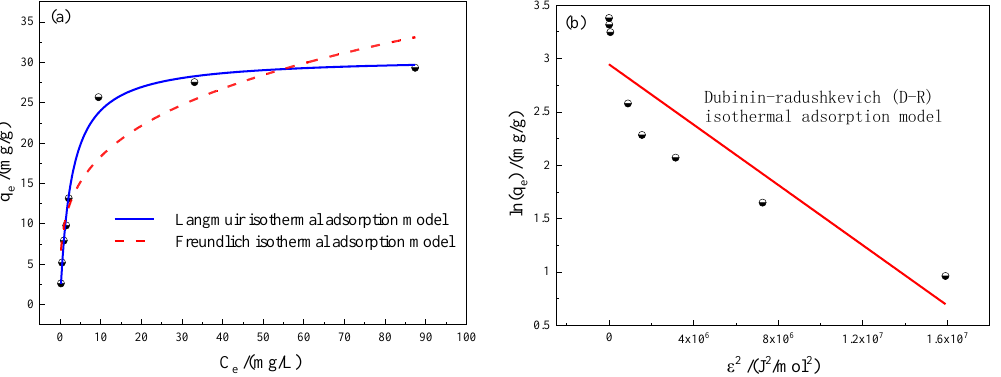
Figure 2. The isotherm plots for the equilibrium adsorption of Sb (III) by FMPAs. [( a ): Langmuir isotherms and Freundlich isotherms of Sb(III), ( b ): D-R isotherms of Sb(III)]. Table 4. The parameters of the isotherm model for Sb( III ) adsorption by FMPAs. Model Langmuir Freundlich Dubinin-Radushkevich(D-R)